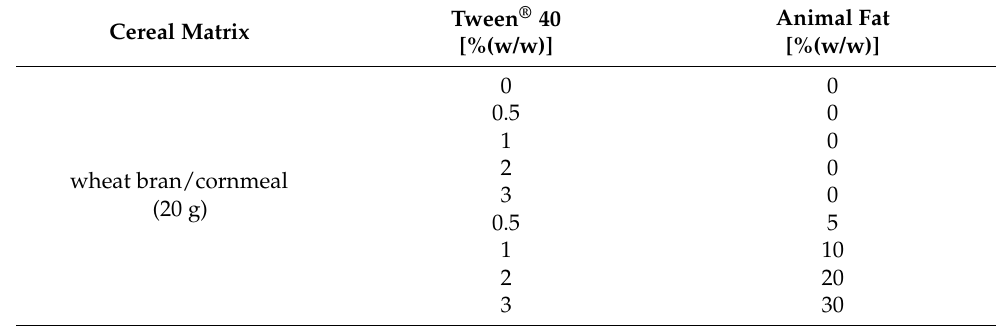
Table 2. Amount of added Tween ® 40 and animal fat to cereal matrixes used for the solid-state fermentation by Umbelopsis